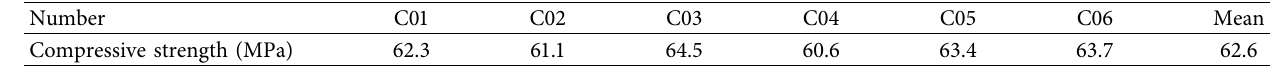
Figure 19: The optimal mixture of polyurethane Table 12: The polyurethane concrete compressive strength.